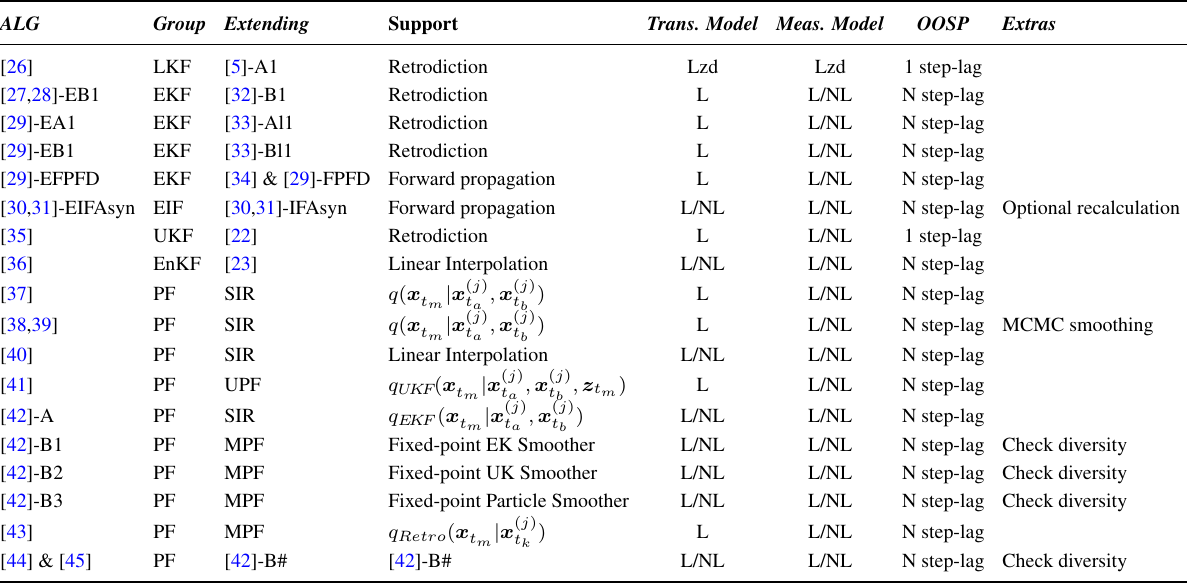
Table 1. OOS Filters for Gaussian Non-Linear